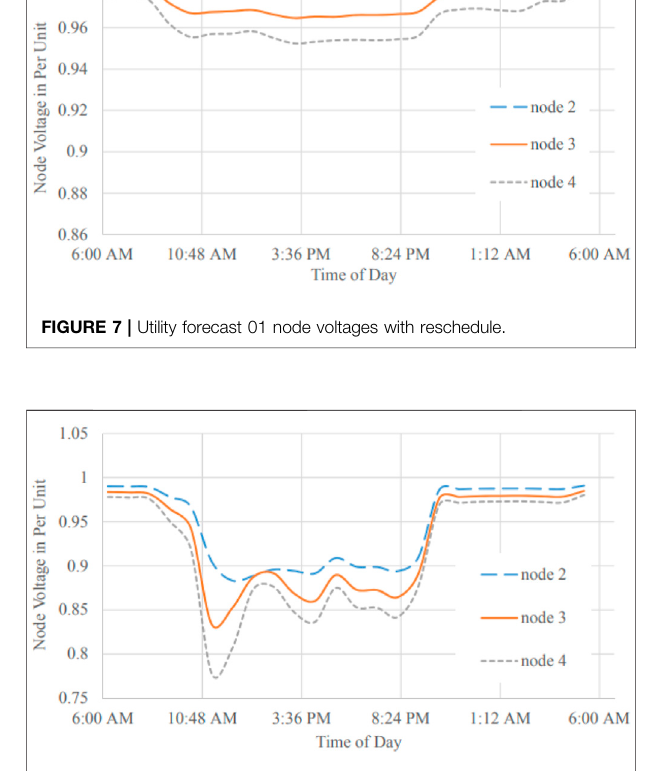
FIGURE 8 | Without rescheduling, node voltages for utility forecast 02.